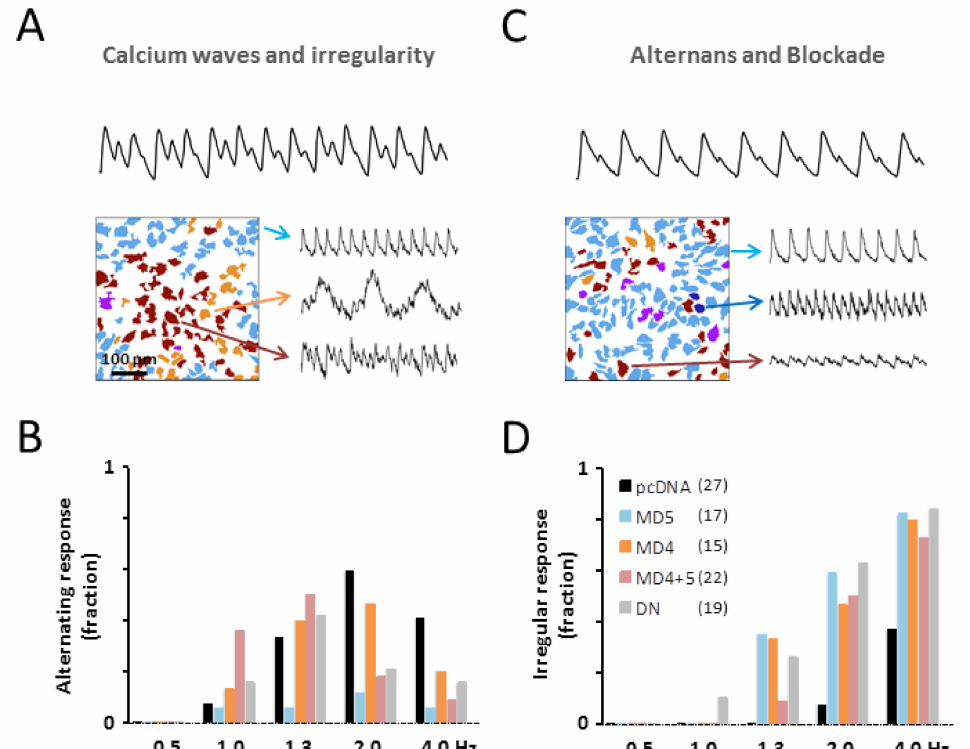
Figure 7. Pitx2 HD-mutants favor arrhythmic beat-to-beat responses. Panel ( A ). Traces of the beat-to- beat response in a whole image field presenting an irregular response. The response of individual myocytes in the field is shown below with traces from selected myocytes showing 1:1 block (light blue), waves (orange) and irregular responses (brown). Panel ( B ). Fraction of preparations transfected with pcDNA, MD5, MD4, MD4+5 or DN showing irregular responses at the stimulation frequency indicated below bars. Panel ( C ). Traces of the beat-to-beat response in a whole image field presenting an alternating response. The response of individual myocytes in the field is shown below with traces from selected myocytes showing 1:1 block (light blue), uniform (blue) and irregular responses (brown). Notice that the MD5 construct did barely induce alternating responses or block at any of the tested stimulation frequencies. Panel ( D ). Fraction of preparations transfected with pcDNA, MD5, MD4, MD4+5 or DN showing an irregular response at the stimulation frequency indicated below bars. When compared with pcDNA, all mutant Pitx2 construct increased the fraction of irregular responses ( p <0.01, ANOVA). Number of experiments is given in